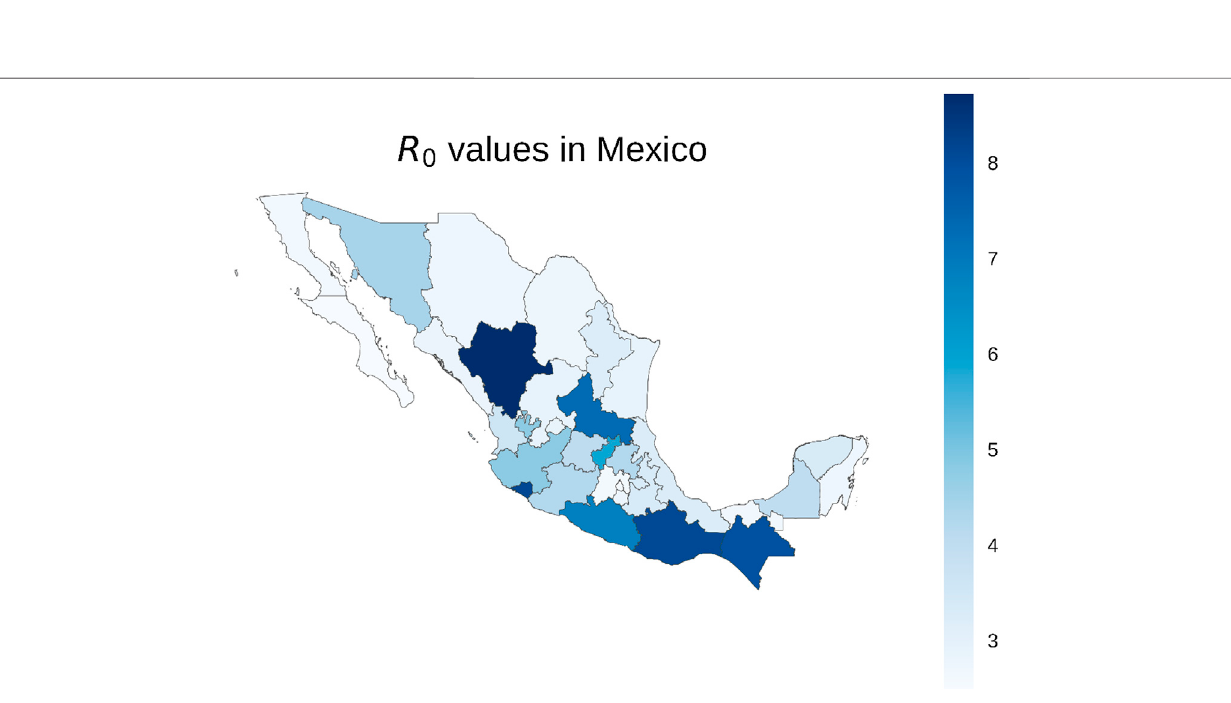
Frontiers in Physics |